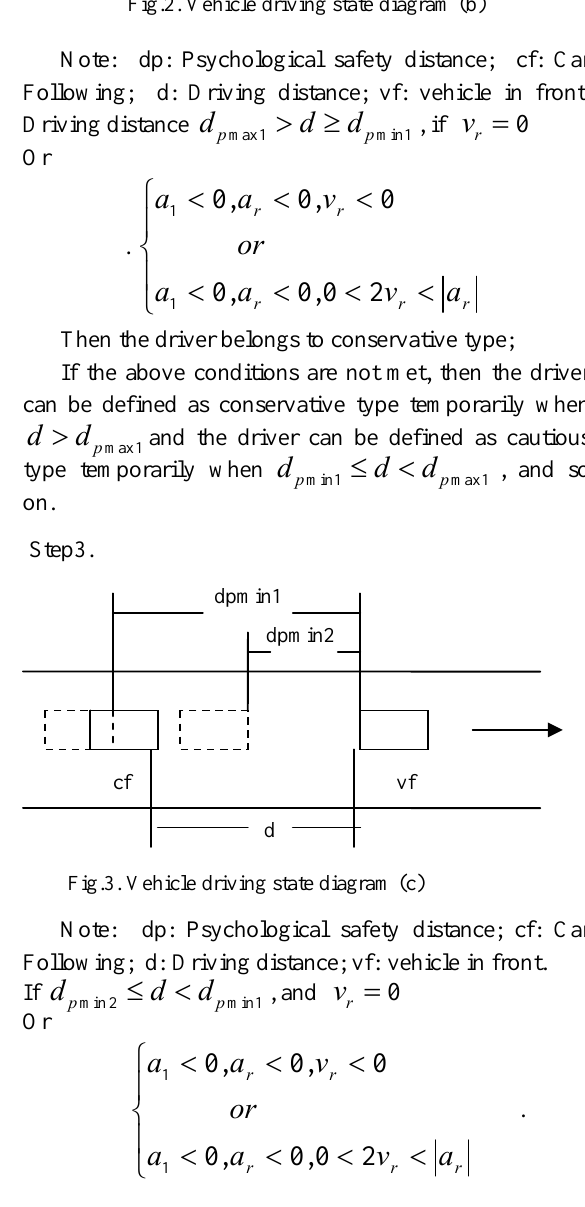
Fig.2. Vehicle driving state diagram (b)